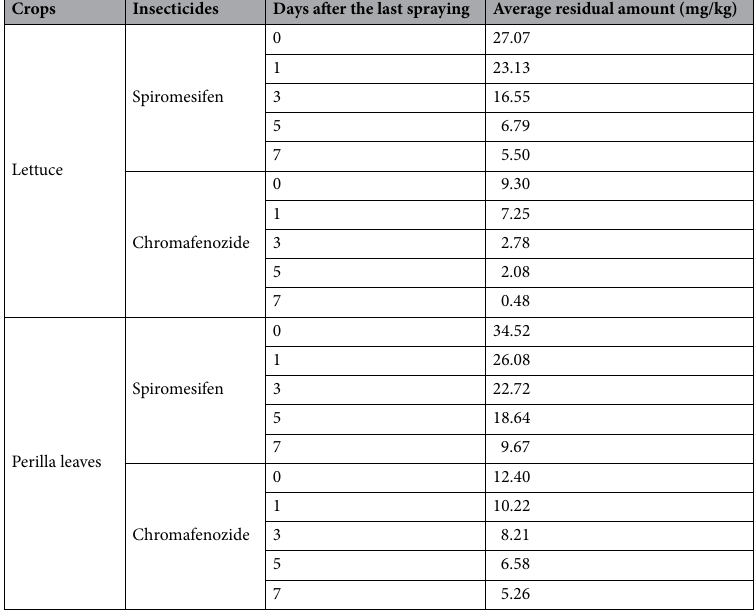
Table 3. Residual amounts of spiromesifen a and chromafenozide in lettuce and perilla leaves. a Total residues of spiromesifen (mg/kg) = spiromesifen + (BSN2060 residue × 1.36).